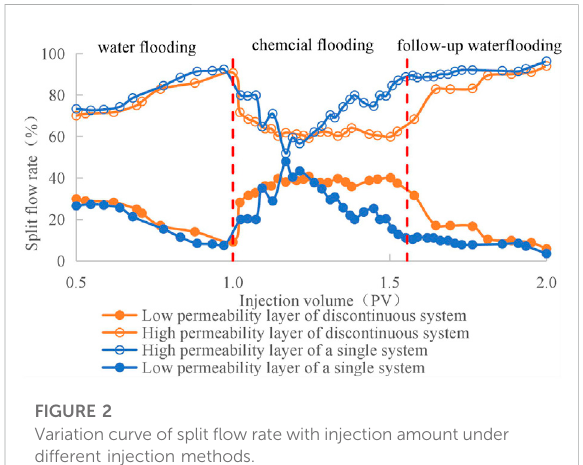
FIGURE 2 Variation curve of split fl ow rate with injection amount under different injection methods.